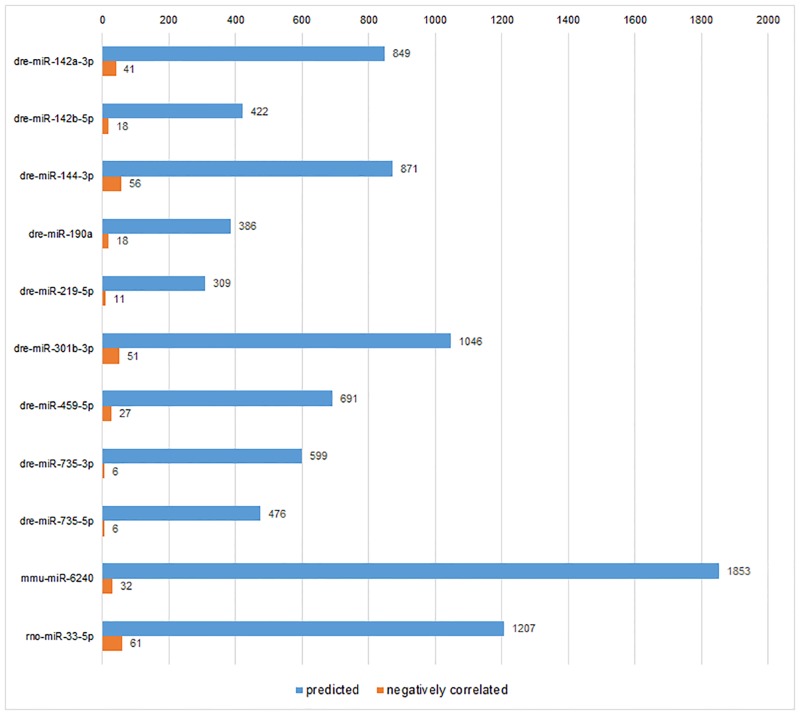
The comparison of numbers of predicted and negatively-correlated target genes in the group of high concentration of BDE47.